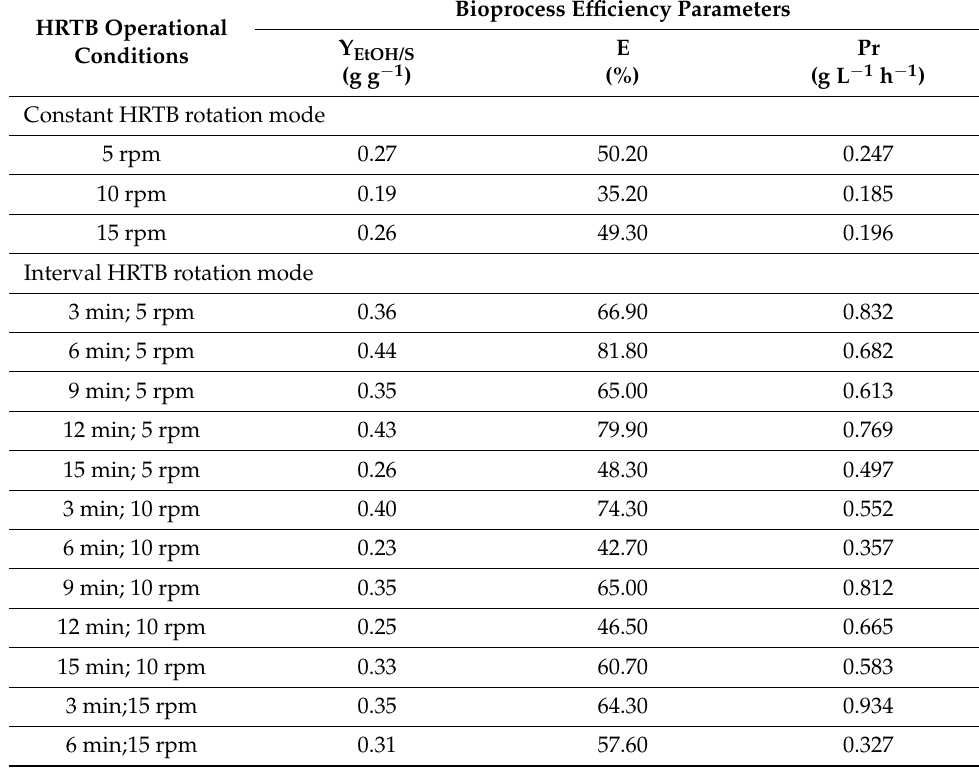
Table 1. Bioprocess efficiency parameters obtained during bioethanol production in the HRTB under different operational